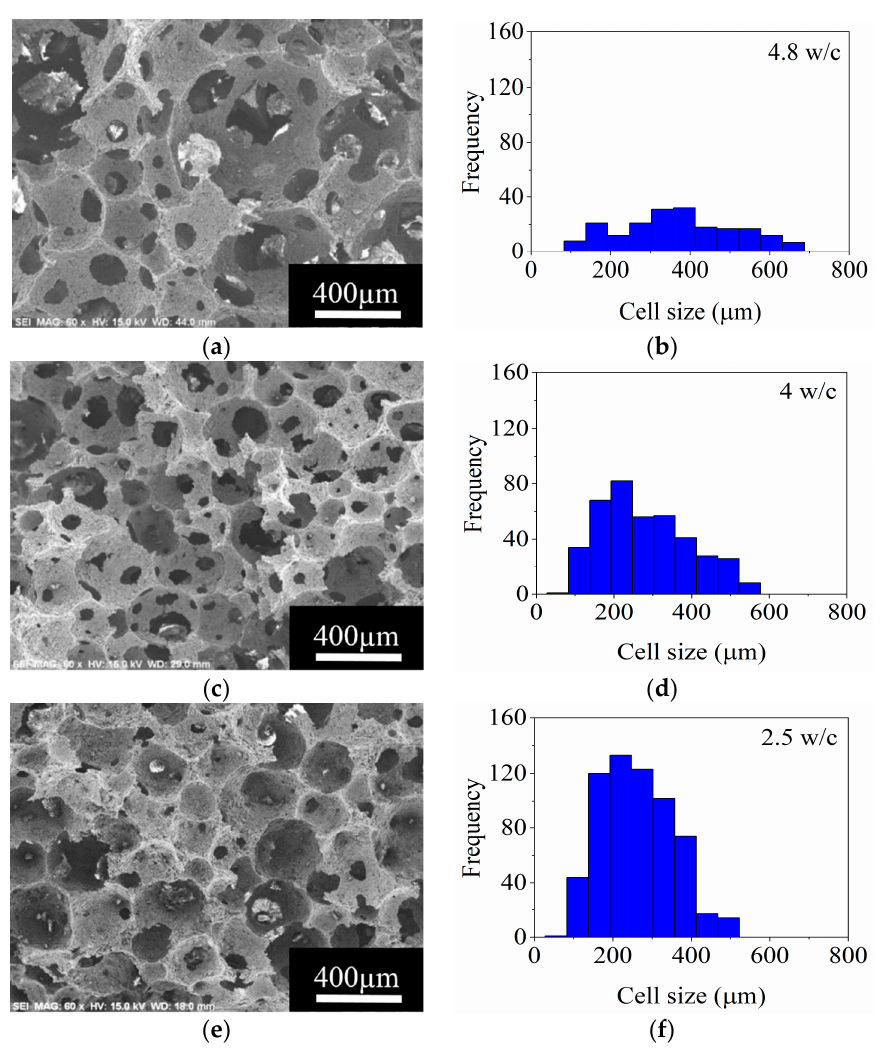
Figure 13. SEM micrographs and frequency histograms of cell size for ceramic foams prepared with ( a ) and ( b ), 7 vol.%; ( c ) and ( d ), 11 vol.%; and ( e ) and ( f ), 21 vol.% MgAl 2 O 4 , respectively.